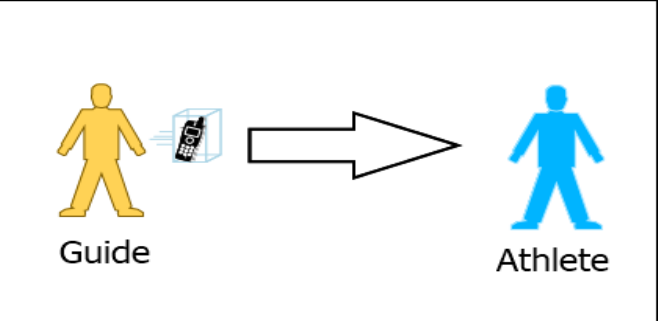
Figure 1: General architecture of the language code system Source: Authors, (2021).